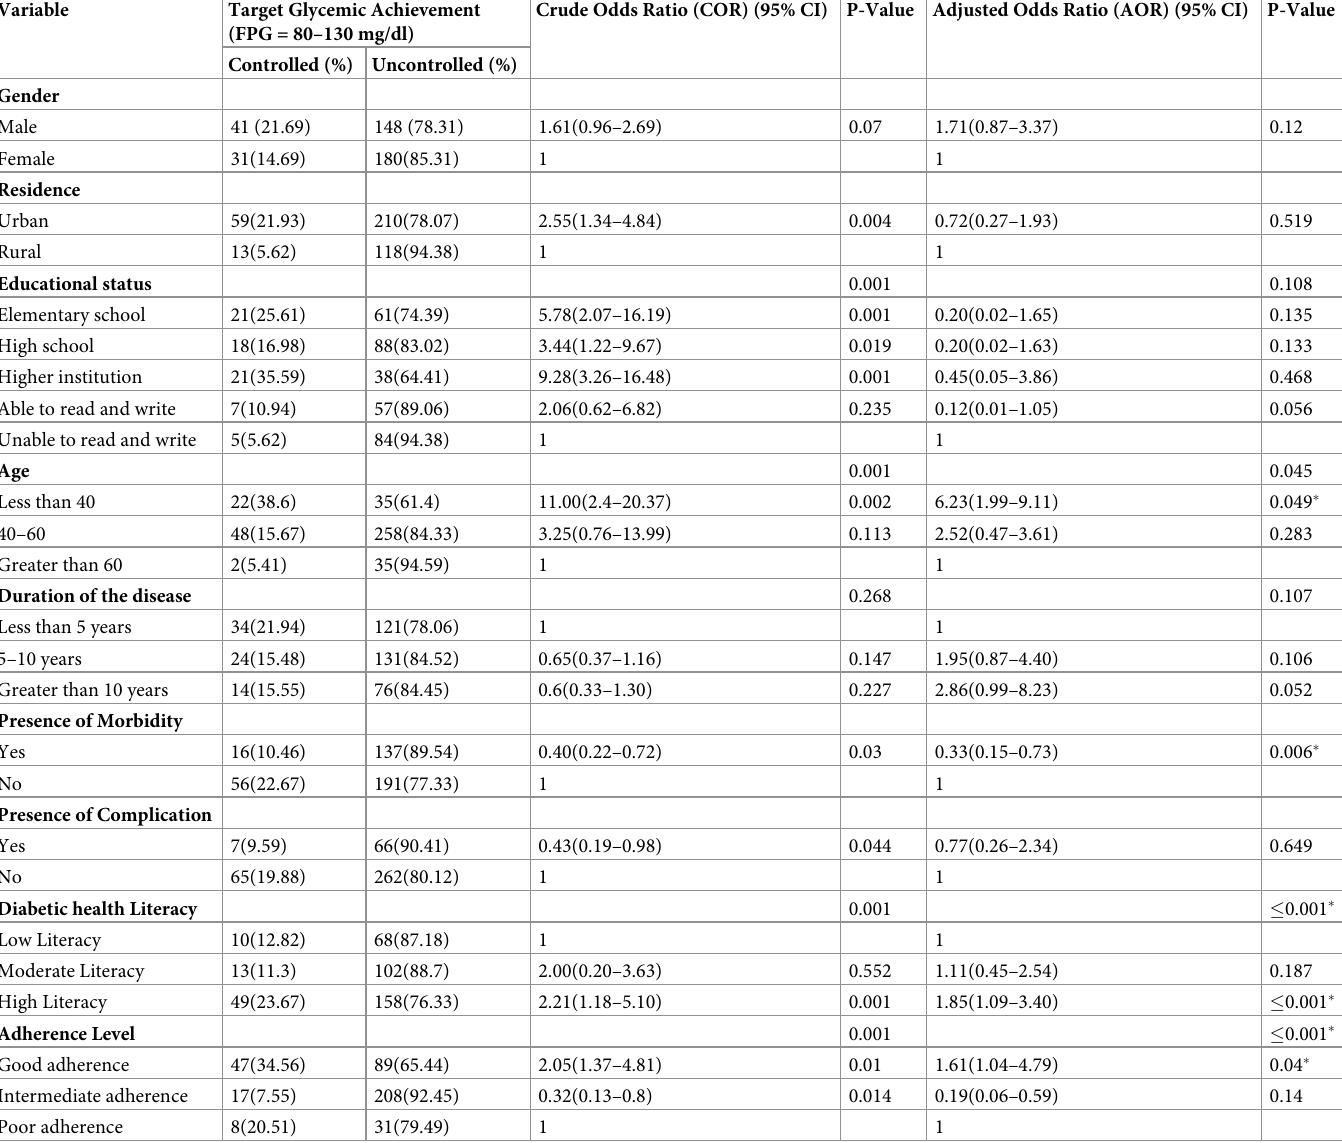
Table 5. Binary and multivariable logistic regression analysis for target glycemic achievement of diabetic patients at UOGCSH, 2019 (N = 400).